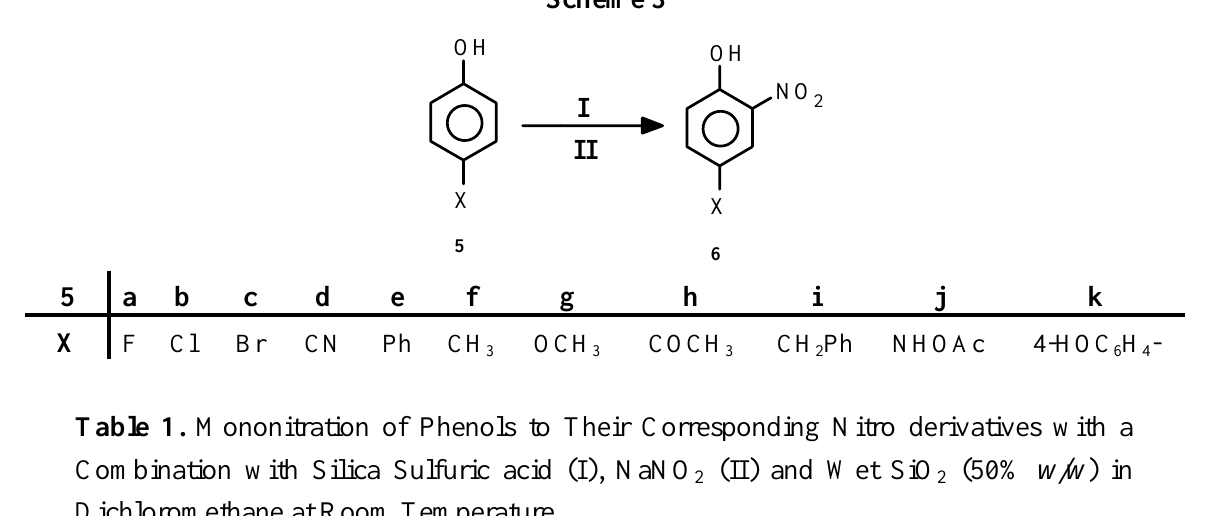
(II) and Wet SiO (50% w/w ) in 2 2